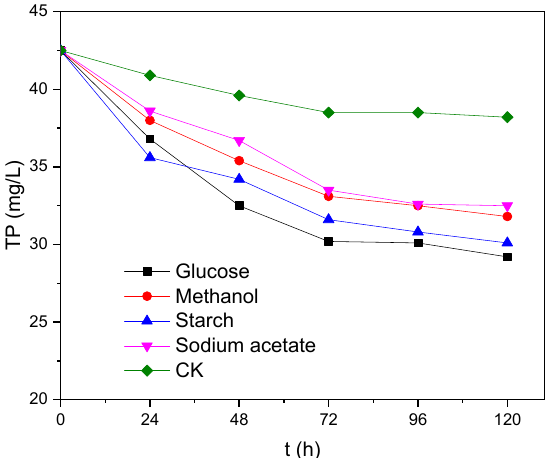
Figure 3. Changes in TP levels over time.